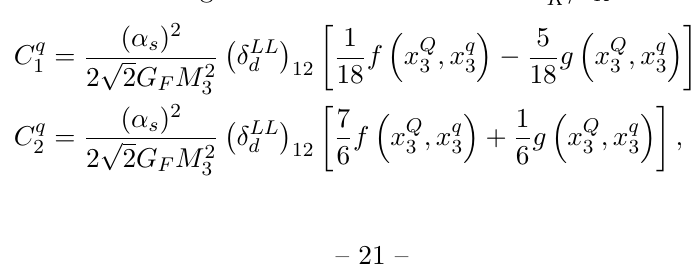
Figure 6 . Scenario C (motivated by Wino Dark Matter) B ( K 0 ! (cid:22) + (cid:22) (cid:0) ) vs. B ( K 0 S (cid:0) (cid:1) (cid:0) (cid:1) for (cid:14) LL 6 = 0 and ( M 3 (cid:1) (cid:22) ) > 0 (upper left), (cid:14) LL 6 = 0 and ( M 3 (cid:1) (cid:22) ) < 0 (upper right), d d 12 12 (cid:0) (cid:1) (cid:0) (cid:1) (cid:14) RR 6 = 0 and ( M 3 (cid:1) (cid:22) ) > 0 (lower left), and (cid:14) RR 6 = 0 and ( M 3 (cid:1) (cid:22) ) < 0 (lower right). The d d 12 12 cyan dots correspond to A (cid:22) > 0 and the orange crosses to A (cid:22) < 0. The vertically hatched area L(cid:13)(cid:13) L(cid:13)(cid:13) corresponds to the SM prediction for A (cid:22) > 0 and the inclined hatched area corresponds to the L(cid:13)(cid:13) SM prediction for A (cid:22) < L(cid:13)(cid:13)